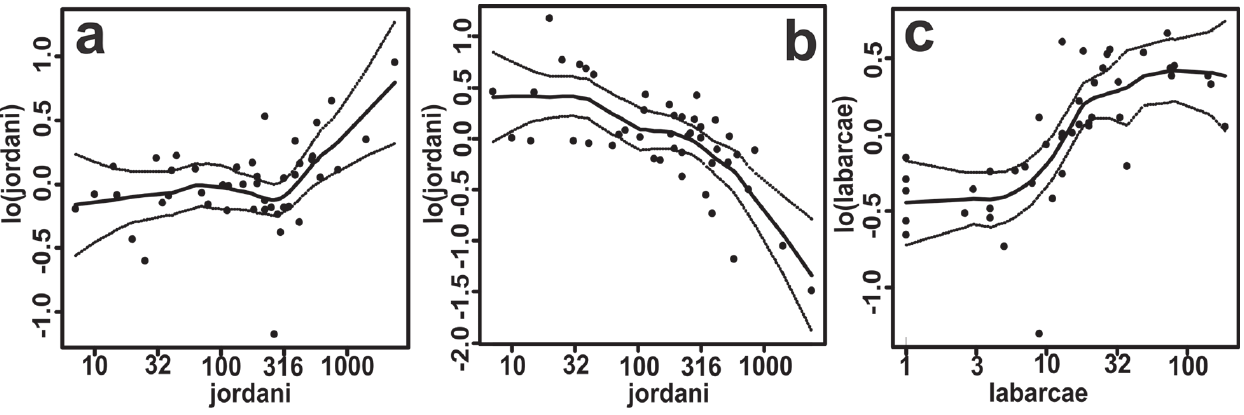
Fig. 4. GAM results for May of species correlation influence on fish density. a: effect of Chirostoma jordani on C. consocium ; b: effect of C. jordani on C. labarcae ; c: effect of C. labarcae on C. consocium . Circles represent the residuals. Spline fit (solid line) is bound by 95% confidence intervals (dotted